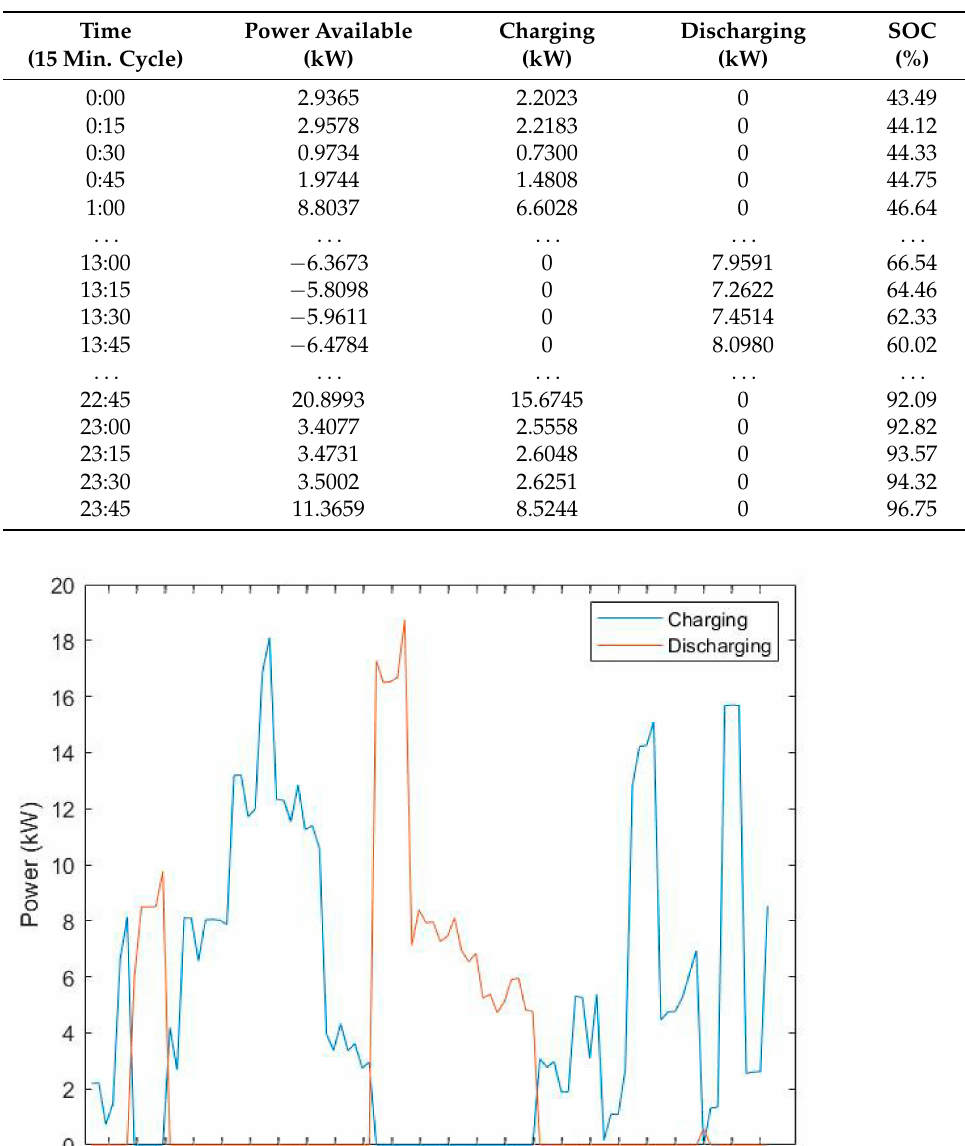
Table 8. Power available, Charging, Discharging and SOC values in Cloudy day.